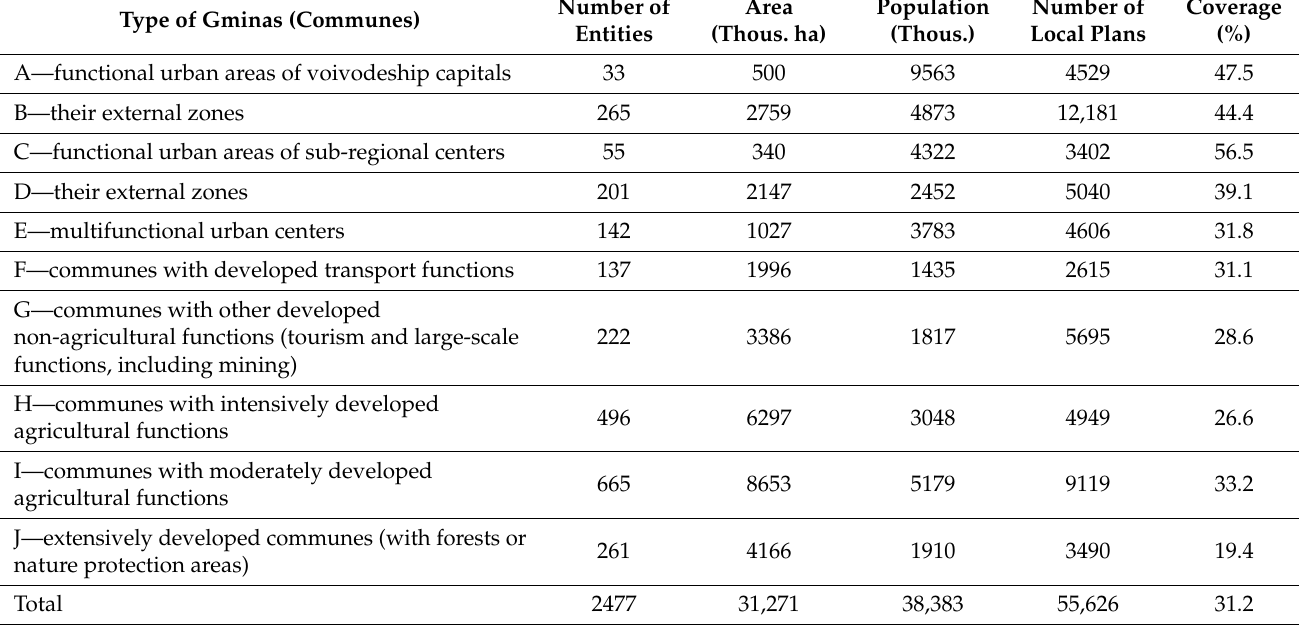
Table 1. Basic information about the analyzed categories of